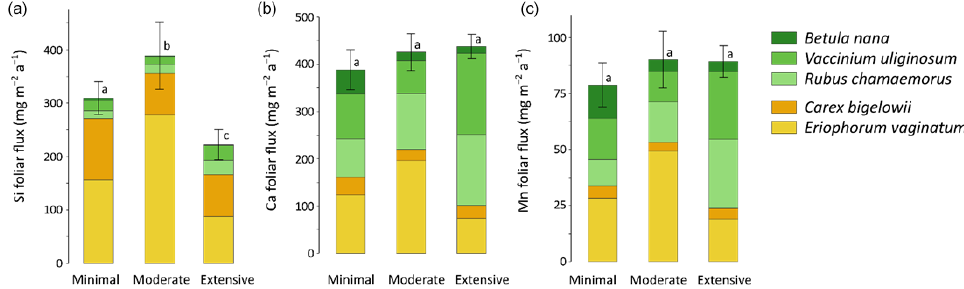
Figure 10. Cumulative annual foliar flux (mgm − 2 a − 1 ) of (a) silicon, (b) calcium, and (c) manganese for the considered plant species between the different permafrost thaw areas from the thermokarst gradient (Gradient) in 2017. Vegetation is sorted by plant functional types: deciduous shrubs and forbs (green) and sedges (yellow). The stages of permafrost degradation are classified as Minimal, Moderate, and Extensive, based on permafrost thaw and subsidence rate. Letters correspond to a one-way ANOVA test and compare total foliar elemental fluxes between the three stages of permafrost degradation. Error bars represent standard